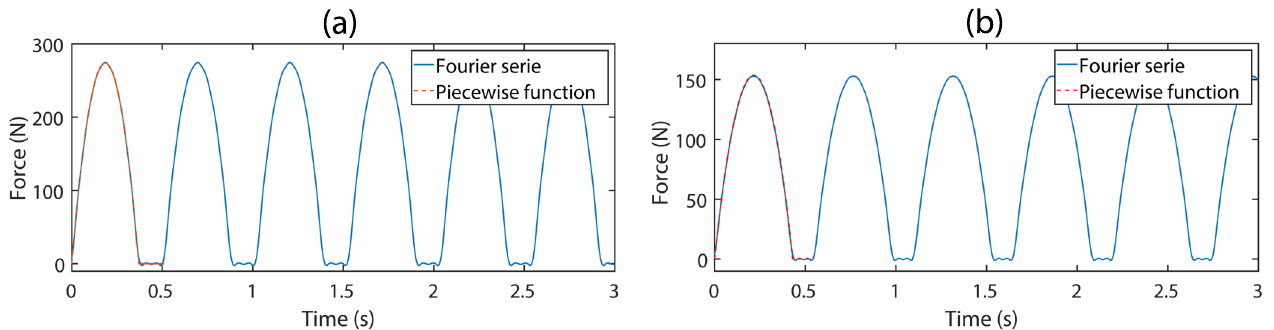
Figure 8. ( a ) Piecewise function for men’s category, defined by expression (38) and representative Fourier series. ( b ) Piece- wise function for women’s category, defined by expression (39) and representative Fourier